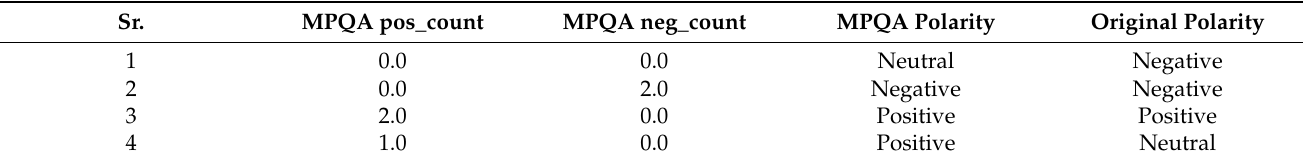
Table 8. A sample of reviews with MPQA subjectivity lexicon scores and their